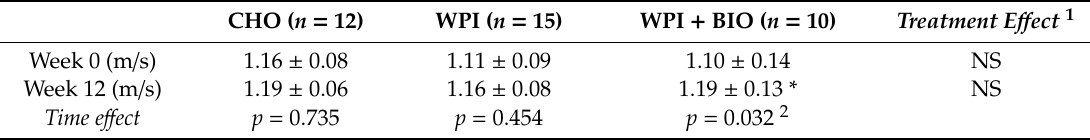
Table 3. Gait speed determined with the 6 m walking time test of elderly subjects with limited mobility treated with a combination of EMS and nutritional supplement: CHO, WPI or WPI + BIO for 12 weeks. CHO ( n = 12)